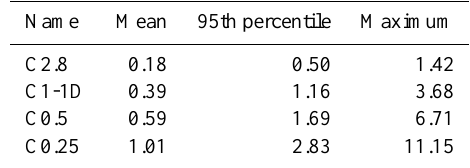
Table 3. Characteristics of low-level wind convergence